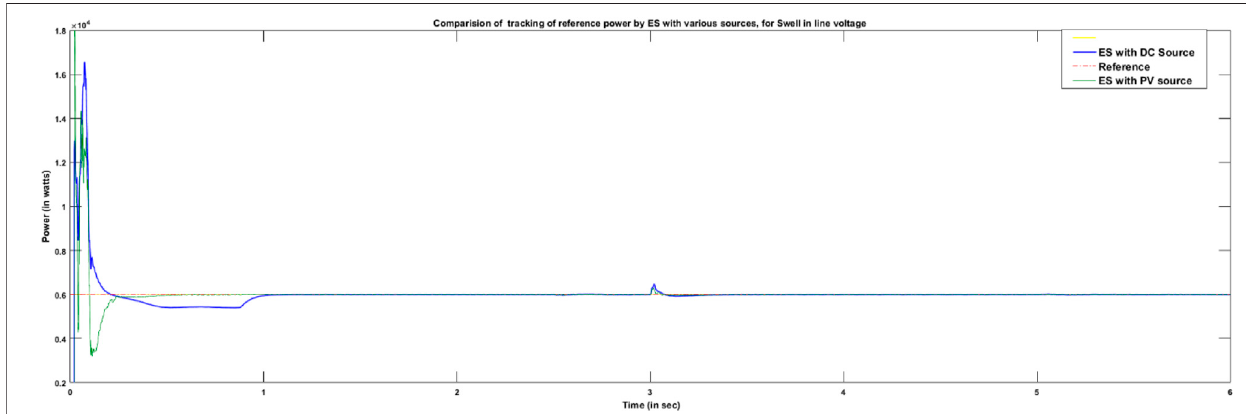
FIGURE 10 | Comparison to track reference power for voltage